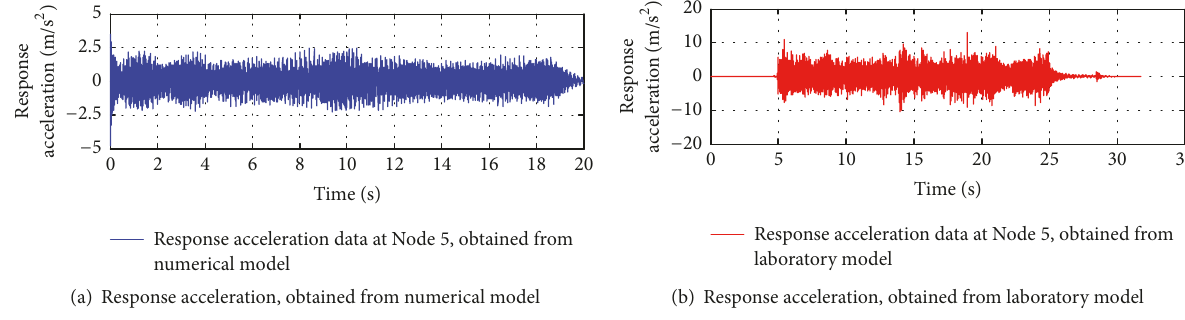
Figure 7: Acceleration data at Node 5, as (a) simulated by the numerical model (blue color) and (b) recorded in laboratory (red color).